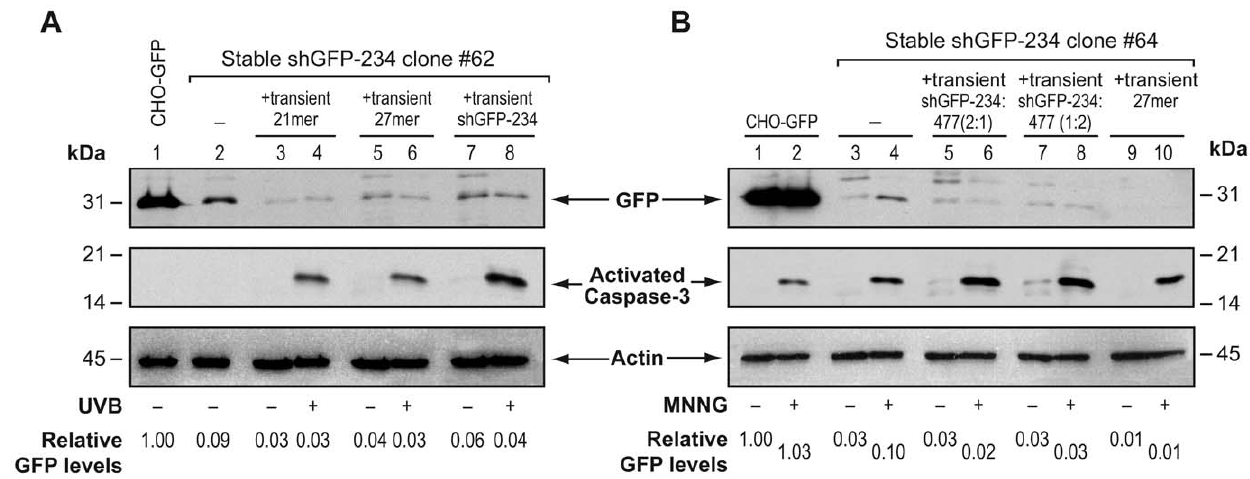
Figure 2. Persistence of GFP-knockdown during apoptosis in stable RNAi cells co-expressing transient RNAi. ( A ) Effect of UVB-induced apoptosis on RNAi of GFP in the stable RNAi clone # 62 supplemented with transient RNAi. The shGFP-234 clone # 62 with a stable RNAi of constitutively expressed GFP was transiently transfected with one of the three GFP-targeting RNAi-inducing agents: 120 pmol of 21mer dsRNA, 2 pmol of 27mer dsRNA or 3 m g of shGFP-234 or with 3 m g of unrelated shRNA–generating DNA vector as control (mock) for transfection. At 48 h after transfection, unirradiated cells were harvested (UVB-) and the rest were treated with 1,600 J/m 2 UVB (UVB + ) and harvested after 72 h. ( B ) Effect of MNNG-induced apoptosis on RNAi of GFP in the stable RNAi clone # 64 supplemented with transient RNAi. The shGFP-234 clone # 64 was transiently transfected with 3 m g of shGFP-234 and shGFP-477 DNA vector (2:1 and 1:2) in combination or with 5 pmol of 27mer dsRNA for 48 h. Mock control was transfected as mentioned above. At 48 h after transfection, untreated cells were harvested (MNNG-), while the rest were treated with 300 m M MNNG (MNNG + ) and harvested 24 h later. For both the panels, the samples were probed for GFP and activated caspase-3, whereas actin probing served as a loading control. The experiments were repeated 4 times with identical results.